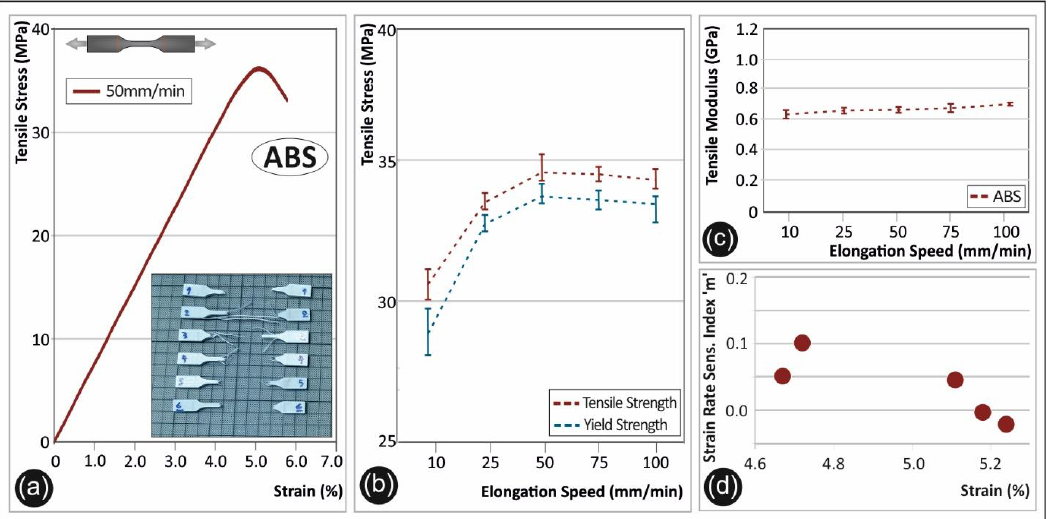
Figure 3. ( a ) Representative tensile stress (MPa)—strain (%) curve of acrylonitrile-butadiene-styrene (ABS) at a 50 mm/min elongation speed, ( b ) average tensile strength and yield strength (with the corresponding standard deviation) for ABS in all five elongation speeds, ( c ) tensile modulus (with the corresponding standard deviation) of ABS under the five different elongation speeds, and ( d ) strain rate sensitivity index “m”—strain (%) graph for ABS.